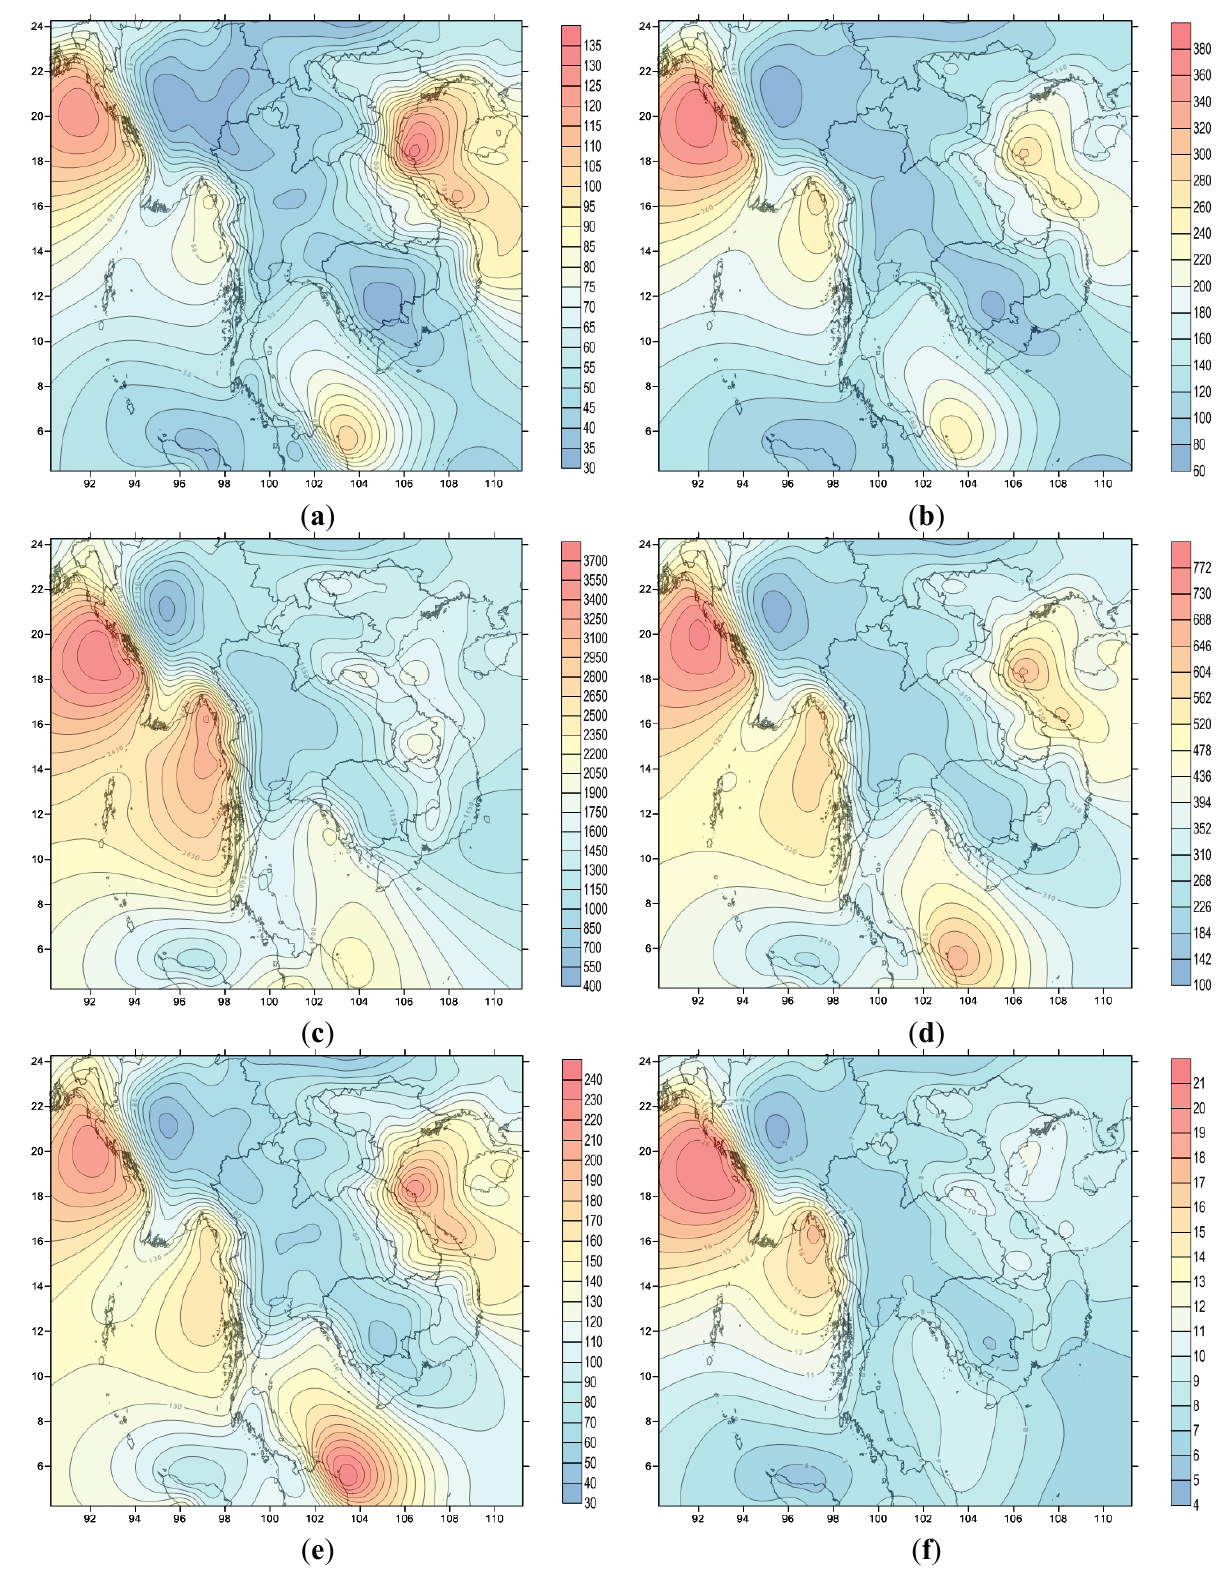
Figure 4. Spatial analysis of intensity indices of mean climatology over the Indochina Peninsula (Mm). ( a ) RX1day; ( b ) RX5day; ( c ) PRCPTOT; ( d ) R95p; ( e ) R99p; ( f )